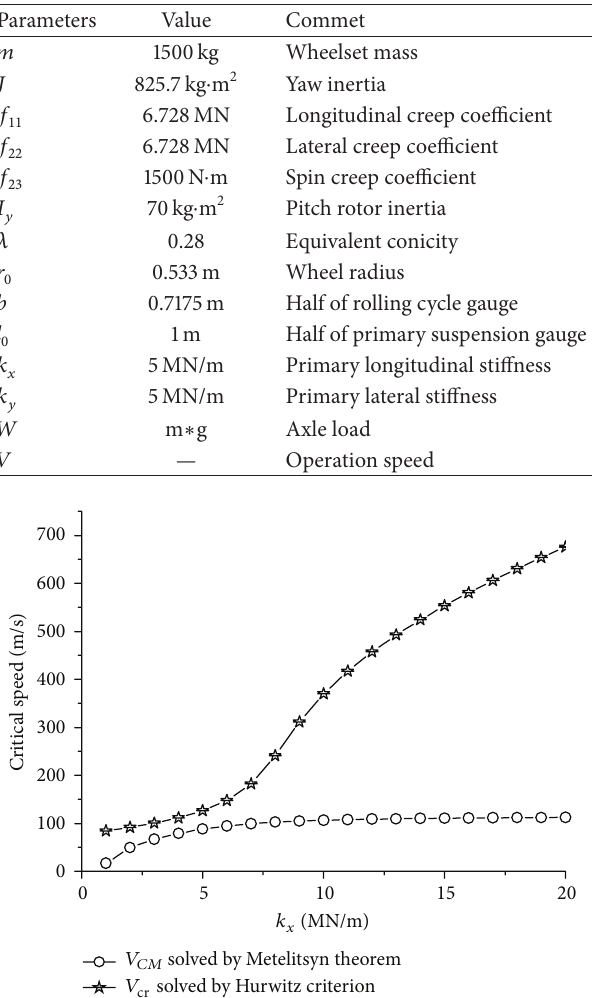
Table 1: Parameters of wheelset.